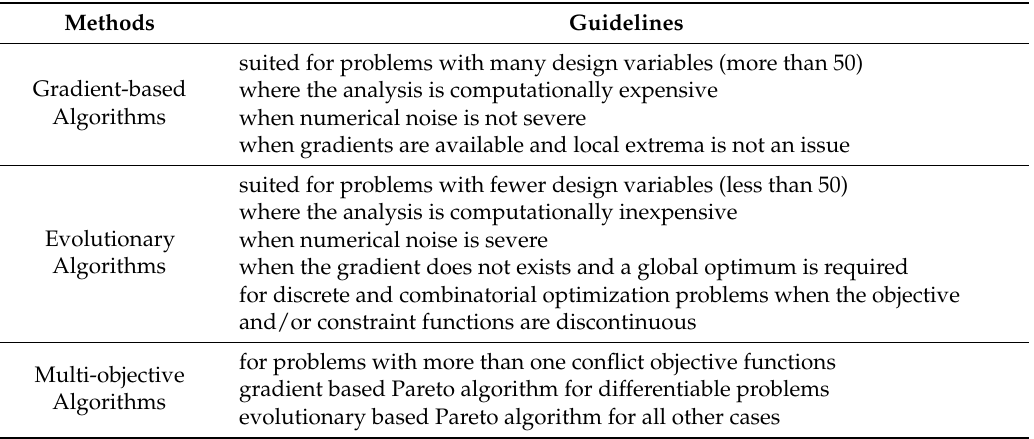
Table 2. Guidelines of Optimization Algorithms